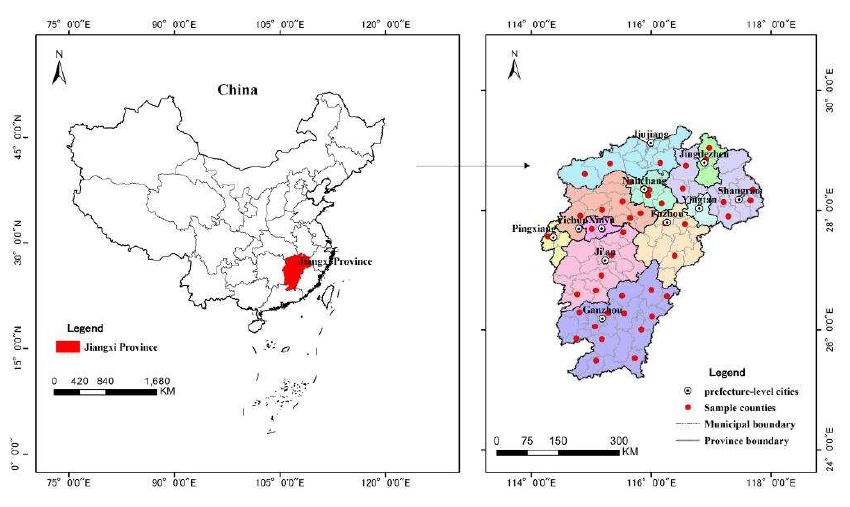
Figure 2. Location of the study